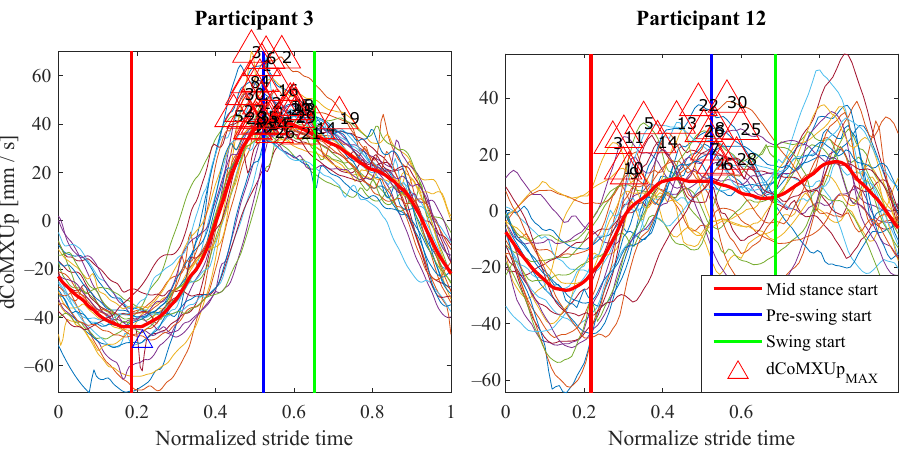
Figure 17. Evolution of the variable dCoMXUp for the tests carried out by P3 and P12. For the latter, the maximums of the variable surrounding pre-swing are distributed in a time interval so large that an accurate phase detection would not be